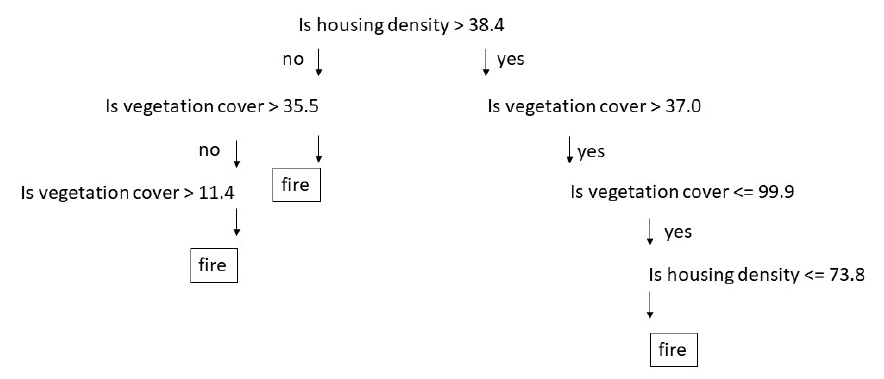
Figure 2. Classification for 2010 fires in the conterminous United States, where fire occurrence is predicted from housing density and percent vegetation cover. Raw output modified to be clearer.